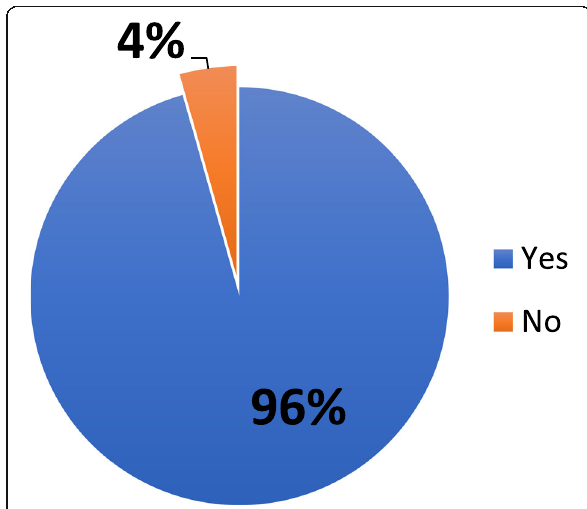
Fig. 1 Frequency of self-medication in the study sample ( N = 160)